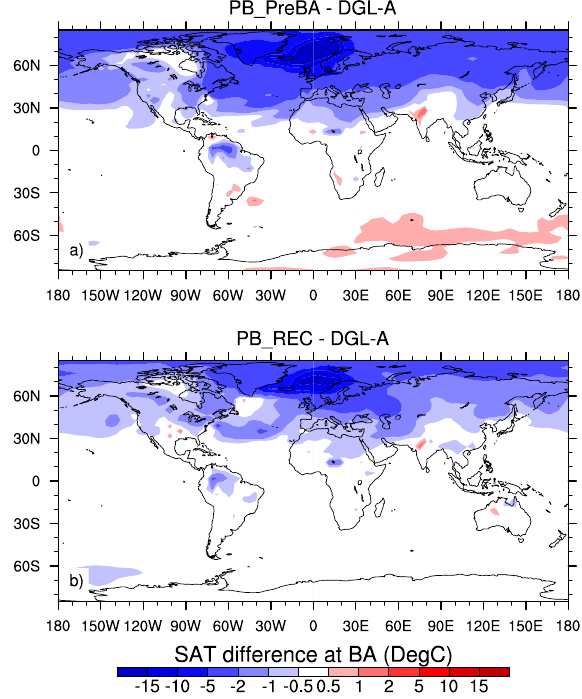
Fig. 4. SAT difference of PB PreBA (a) and PB REC (b) to DGL- A run at the time of 14.32ka (maximum AMOC overshoot, seen in Fig.